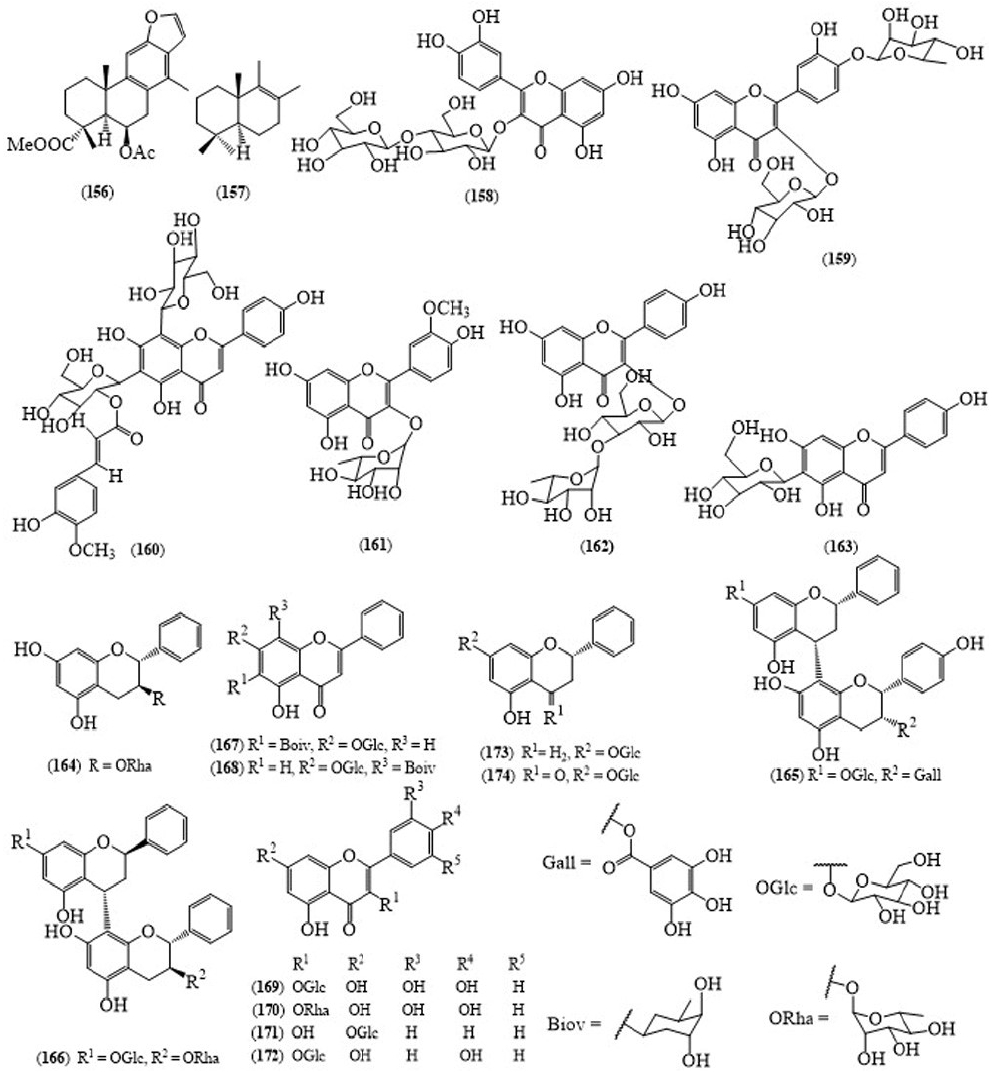
Figure 13. Structures of selected compounds isolated from Acacia pennata.